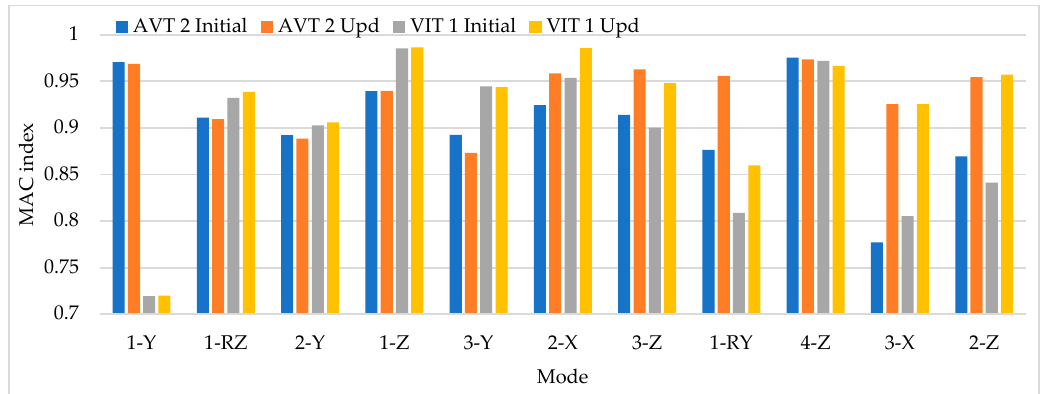
Figure 17. MAC index update by identified experimental modes.